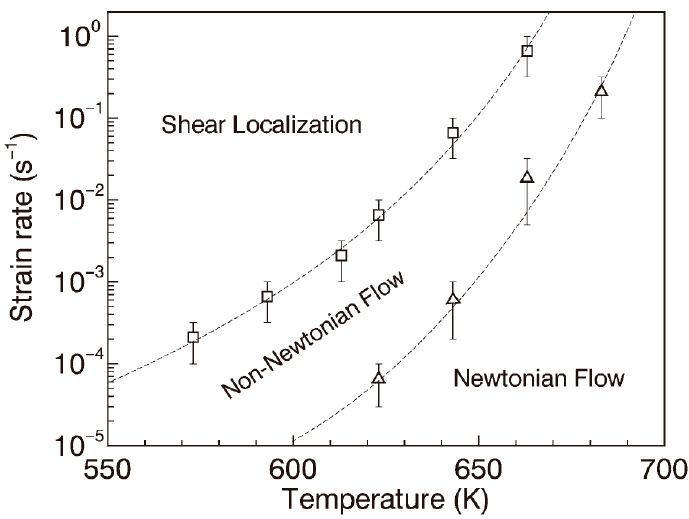
Figure 12. The boundaries between the three distinct deformation modes of Zr-MG [21]. According to the results, the boundary from shear localization deformation to non- Newtonian flow deformation was obtained by fitting.